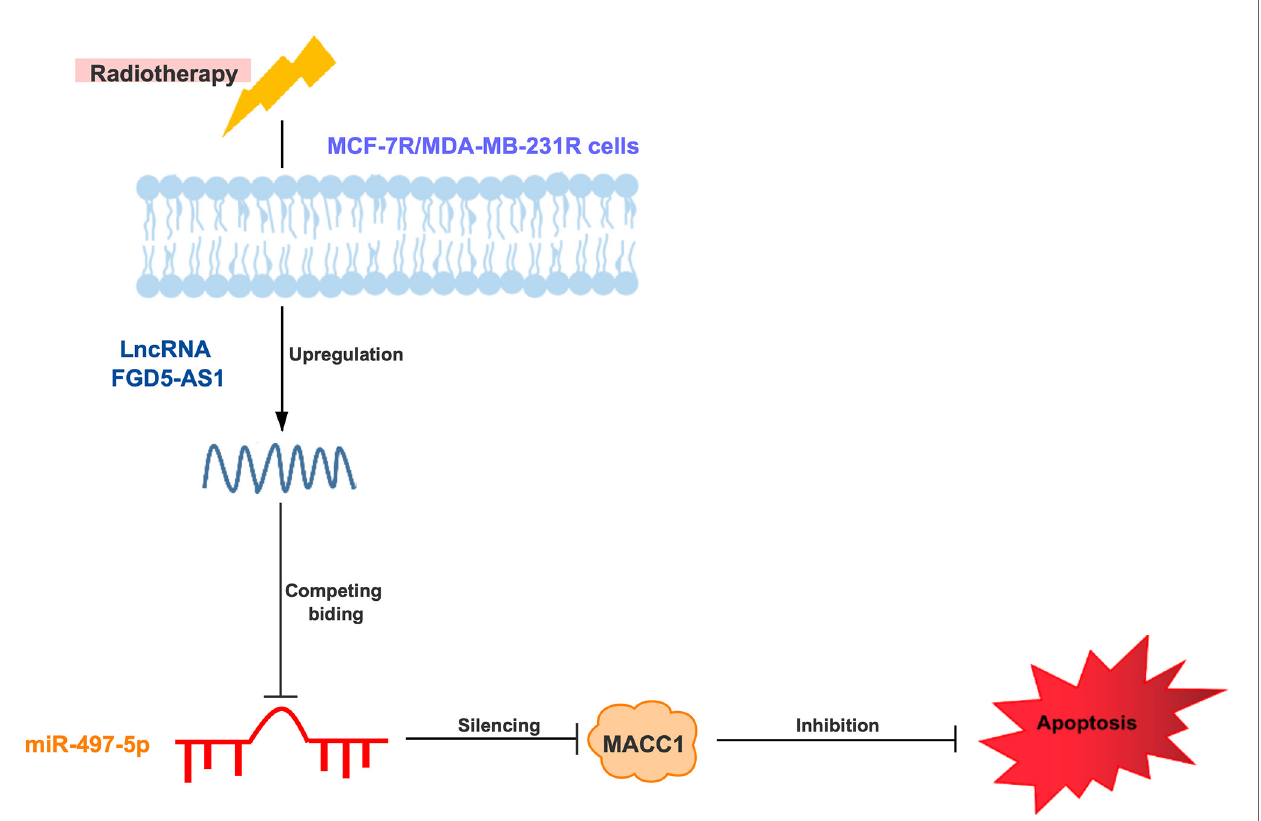
FIGURE 7 | Schematic diagram of lncRNA FGD5-AS1/miR-497-5p/MACC1 axis to regulate MCF-7 or MDA-MB-231 cells